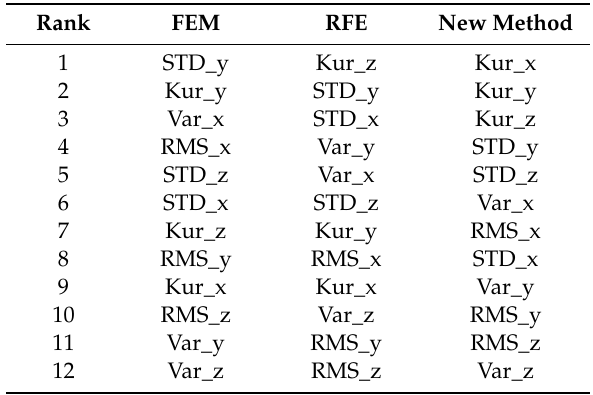
Table 3. Feature ranking by di ff erent feature selection